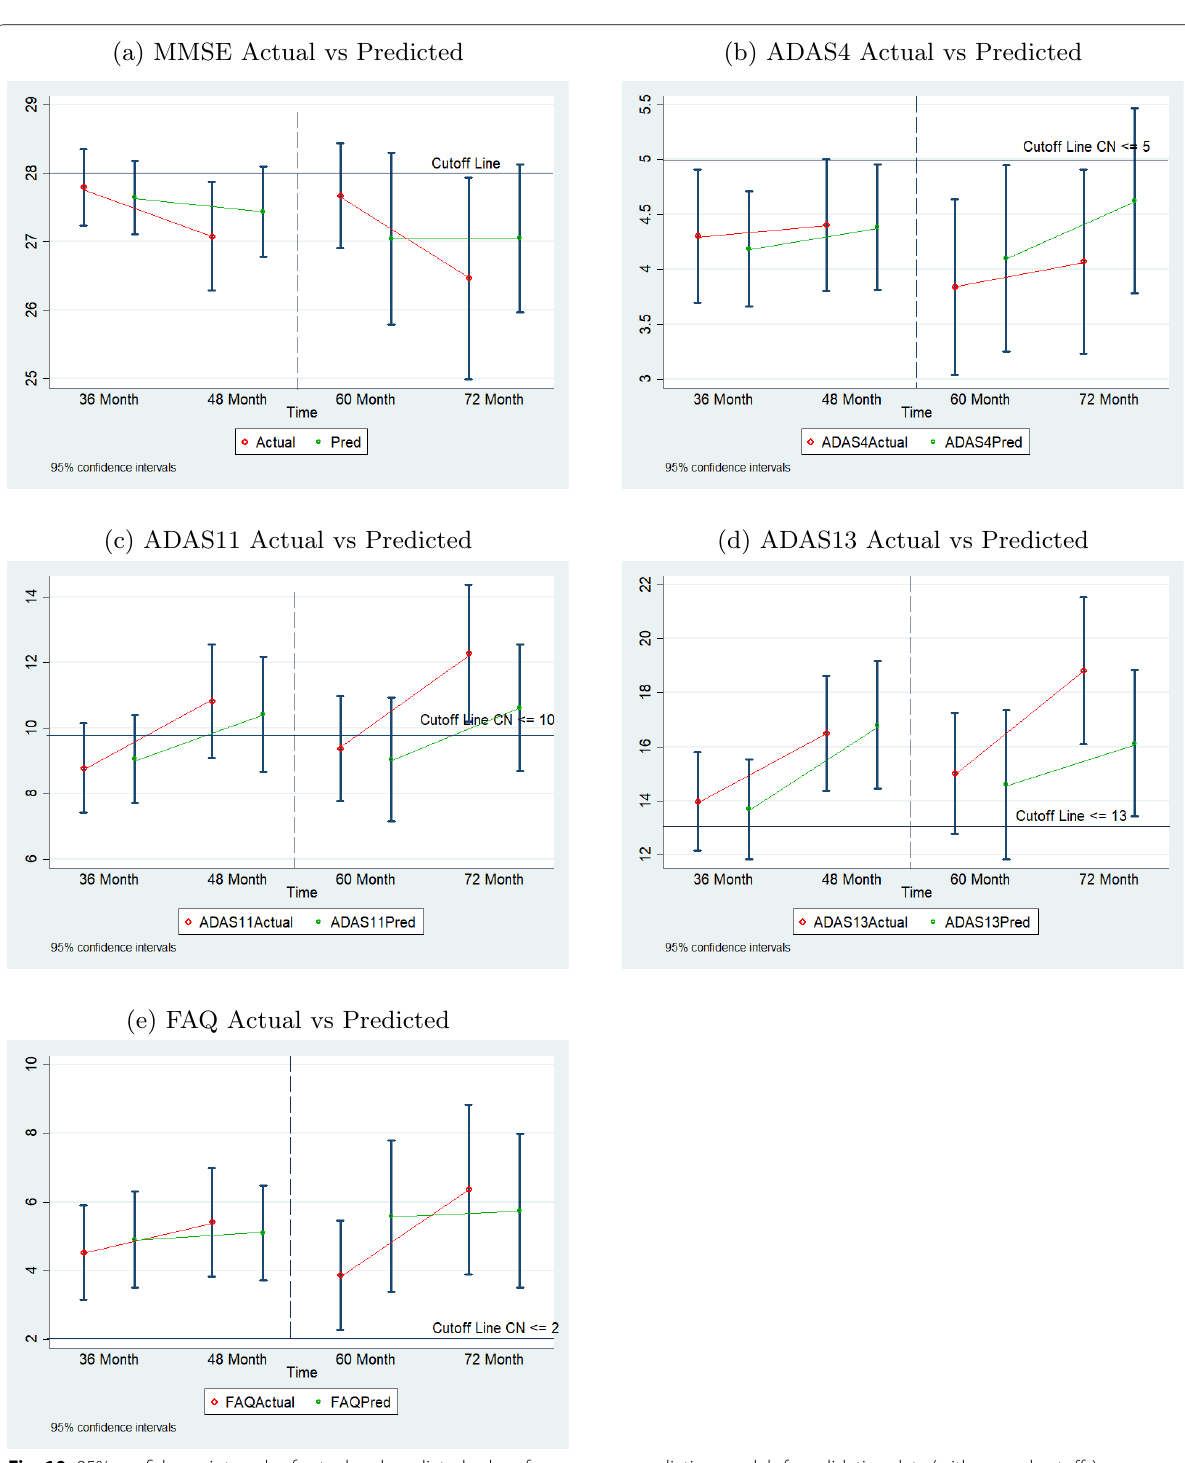
Fig. 10 95% confidence intervals of actual and predicted values for sequence prediction models for validation data (with normal